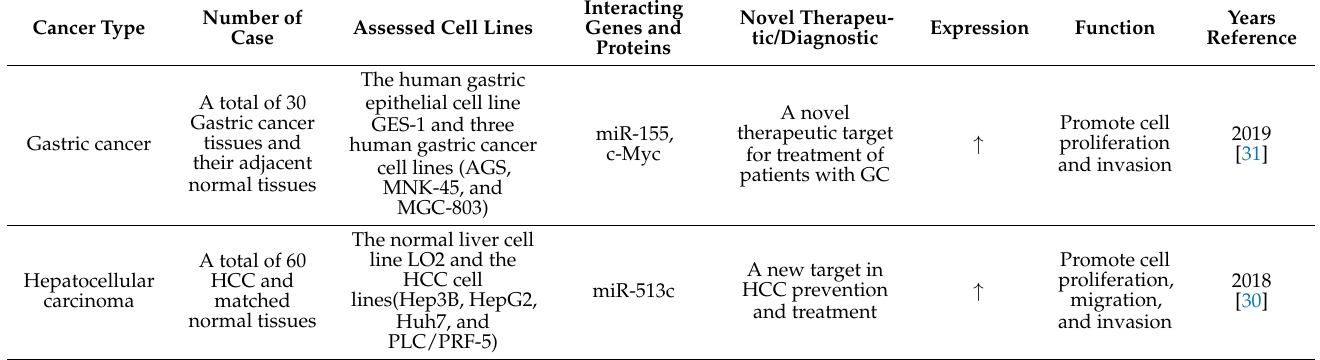
Table 3. Functional characterizations of FLVCR1-AS1 in multiple human cancers. ↑ in the table indicates